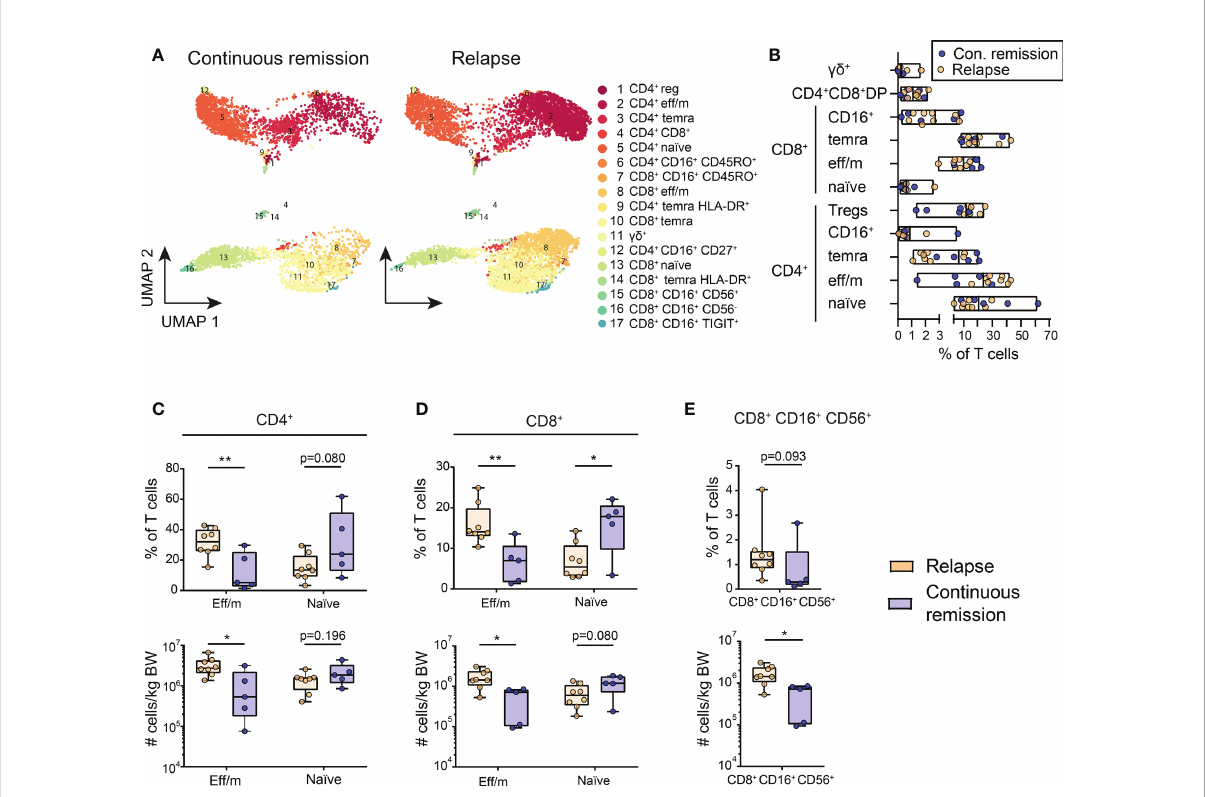
FIGURE 2 Differentially activated T cell clusters in the DLI cell product are associated with outcome. (A) Cluster analysis identi fi ed 17 different T cell populations within the DLI cell product. These are shown in Uniform Manifold Approximation and Projection (UMAP) for patients with continuous remission post DLI (n=5) and for patients with relapse post DLI (n=8) during the 24 months follow-up. The details on the 17 identi fi ed clusters are listed in Supplementary Table S4. (B) Composition of DLI cell products is shown, displaying the frequency of main T cell subsets. Each dot represents one DLI, with color-coding indicating the outcome to the cell product during a 24 months follow-up post DLI (blue = continuous remission, orange = relapse). Lines represent mean and bars represent the minimum and maximum. (C – E) Comparison of frequencies and cell counts of fi ve clusters of the DLI cell product bags, with (C) showing results for CD4 + and (D) for CD8 + effector memory (eff/m) and naïve clusters and (E) CD8 + CD16 + CD56 + cluster. Grouping is based on the DLI cell product recipient ’ s outcome during a 24 months follow-up with continuous remission (blue, n=5) and relapse (orange, n=8). Clusters are named as in (A) . (C – E) Lines represent median, boxes represent 25th and 75th percentile and whiskers represent minimum and maximum. Statistical analysis (C – E) was performed by Student t test or Mann-Whitney test (two-tailed). *p<0.05,